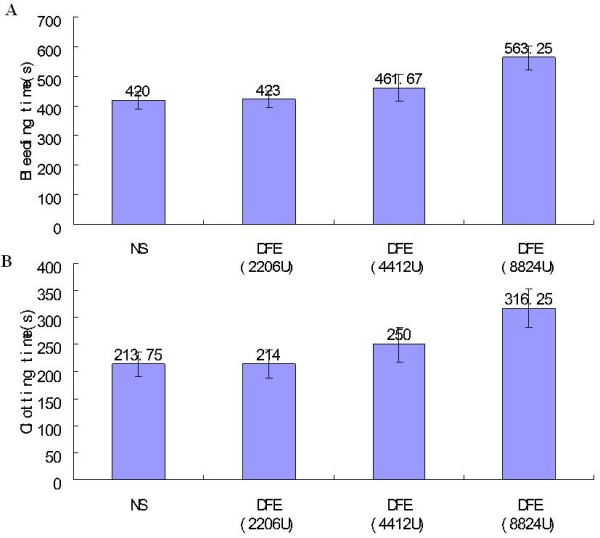
Bleeding time (A) and clotting time (B) of mice treated with DFE (2206U, 4412U and 8824U).